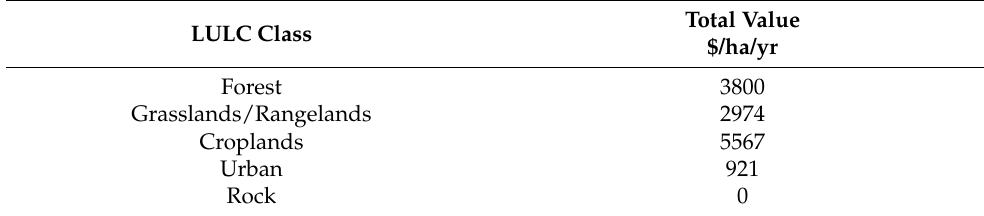
Table 1. Coefficients associated with the LULC classes (source of data